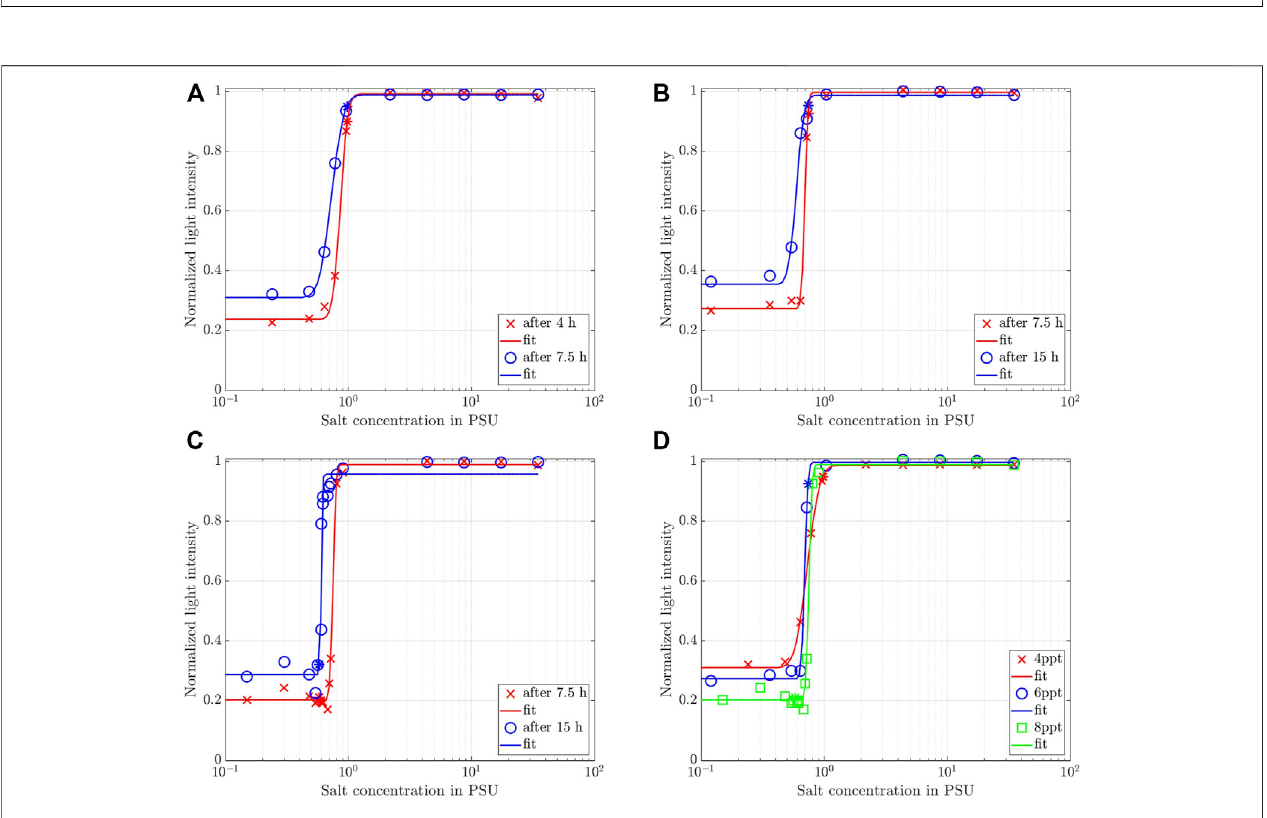
FIGURE 6 | Normalized light intensity for 4 ppt recorded at the observation level marked in Figure 5A at two different observation times as a function of salinity for (A) 4 ppt, (B) 6 ppt, (D) 8 ppt. Solid lines represent a best fi t of Eq. 7 . (D) Synoptic comparison among the three different clay concentrations at t (cid:1) 7 . 5 h.